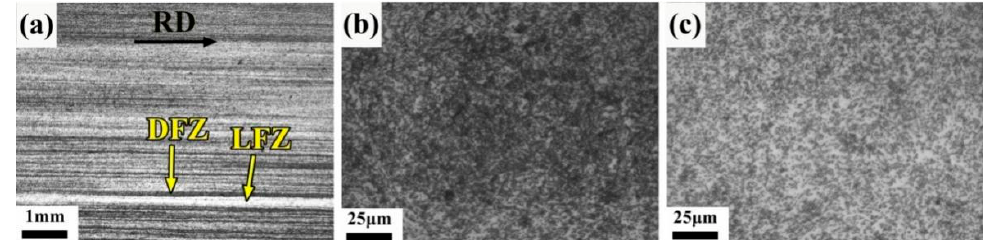
Figure 2. OM images of the flow lines in hot-rolled bearing steel: ( a ) image showing the DFZ and LFZ; ( b ) magnified image of the DFZ; ( c ) magnified image of the LFZ.